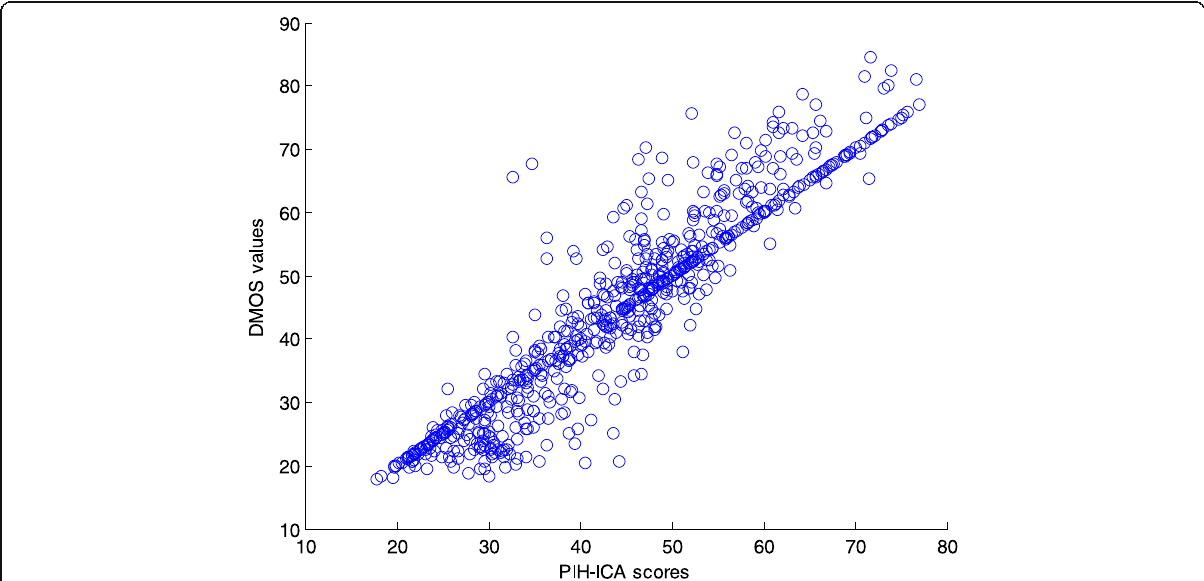
Fig. 6 The scatter of the subjective consistence of the PIH-IQA method in the database